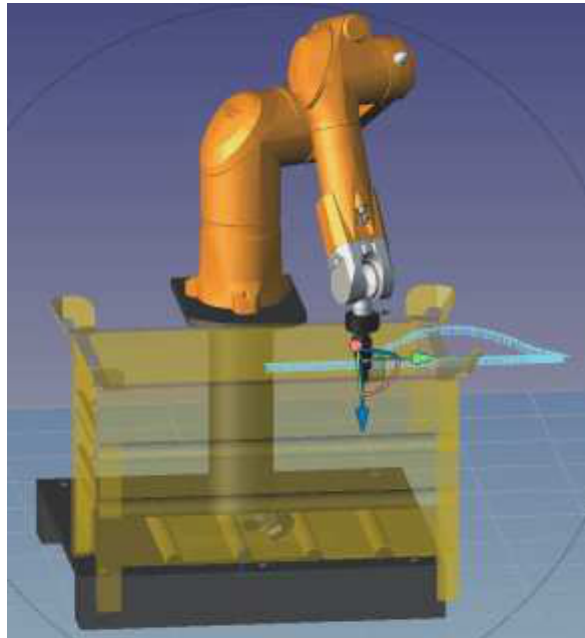
Figure 3. Simulation result of the use of the toolbox implementing obstacle avoidance on the Stäubli Robotics Suite (SRS) simulator. The straight trajectory represents the original trajectory free of obstacles in front of an adaptation online with the presence of a basket.